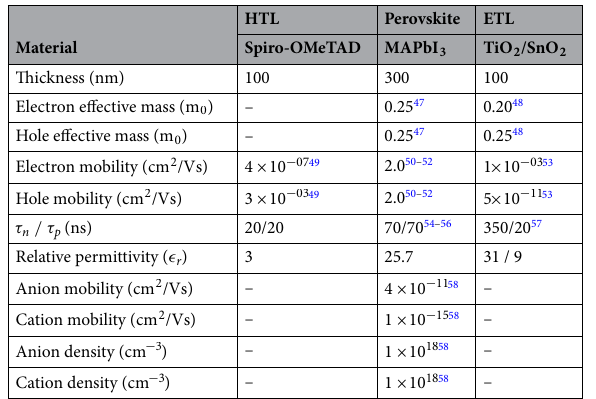
Table 1. Parameters used in the modeling in this